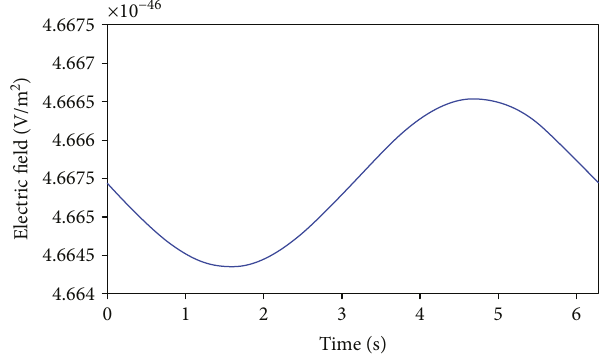
Figure 2: Variations in received electric fi eld as a function of time when spherical particles move at the angular velocity of 1 rad/s.